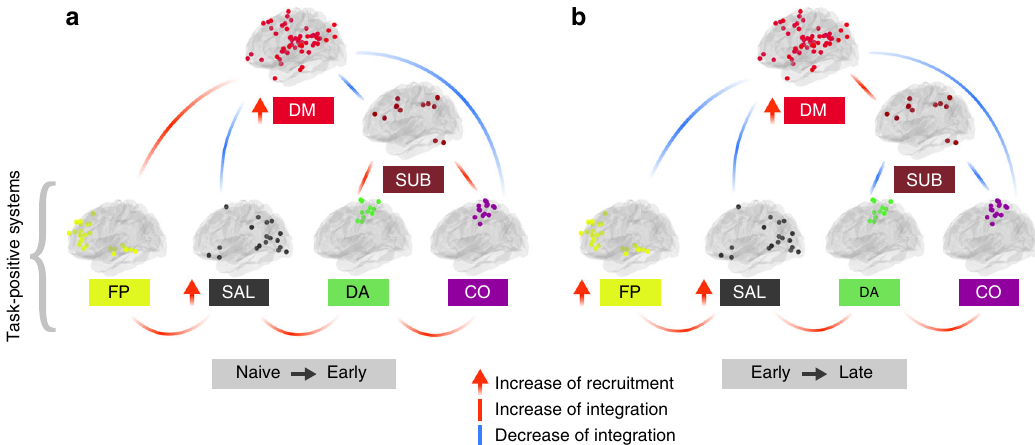
Fig. 8 Schematic summarizing the main changes in recruitment and integration of large-scale systems observed over the course of working memory training. We observed a gradual increase of the integration between task-positive systems (FP: frontoparietal, SAL: salience, DA: dorsal attention, CO: cingulo-opercular), greater recruitment of the default-mode (DM) system, and decreased DM – CO and DM – SAL integration. In the early phase of training ( a ), the experimental group displayed an increased FP – DM integration, and increased integration of the subcortical (SUB) system with the DA and CO systems. In the late stage of training ( b ), the FP system reduced its integration with the DM system and the SUB system increased its integration with the DM system,while decreasing coupling with task-positive